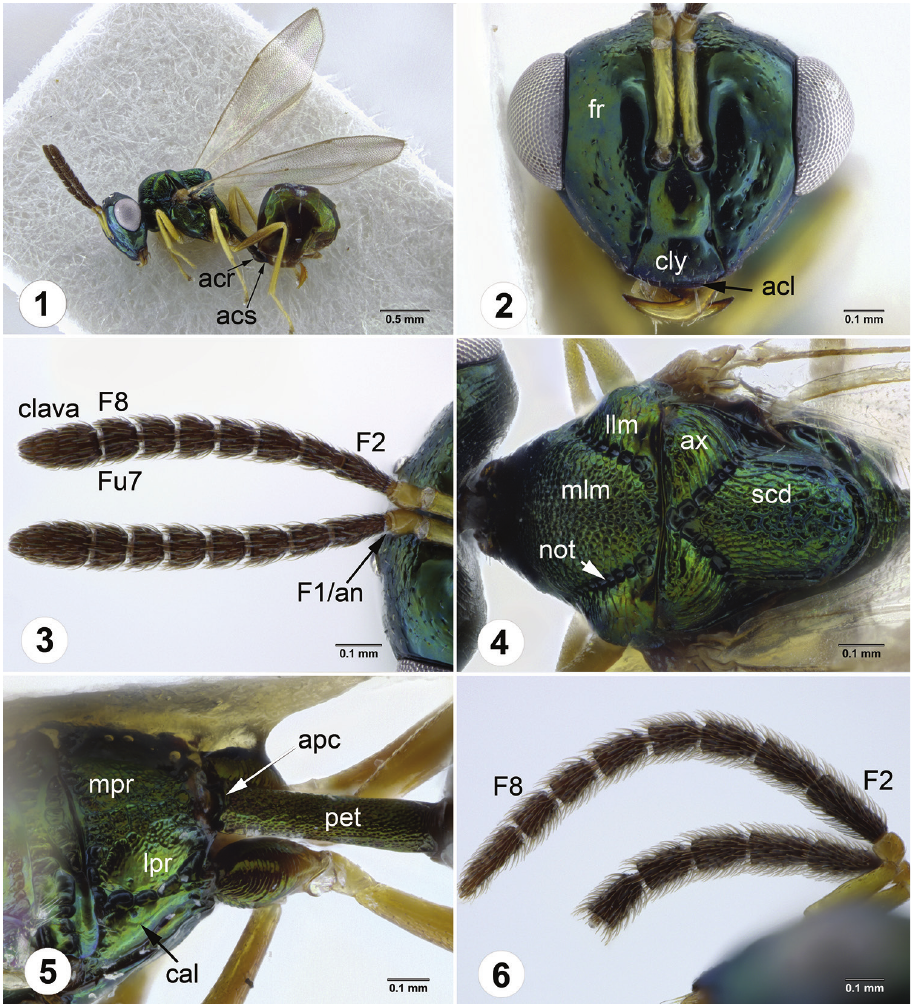
Figures 1–6. Australosema politurae . Paratype female: 1 habitus, lateral 2 head, anterior 3 antennae, ventral 4 mesosoma, dorsal 5 propodeum and petiole, oblique dorsal. Paratype male: 6 antennae, lateral. acl = anteclypeus; acr = acrosternite; acs = antecostal sulcus; apc = anterior petiolar carina; ax = axilla; cal = callus; cly = clypeus; F = flagellomere; fr = frons; Fu = funicular; F1/an = anellus; llm; mesoscutal lateral lobe; lpr = lateral propodeal disc; mlm = mesoscutal midlobe; mpr = median propodeal disc; pet = petiole; not = notauli; scd = scutellar